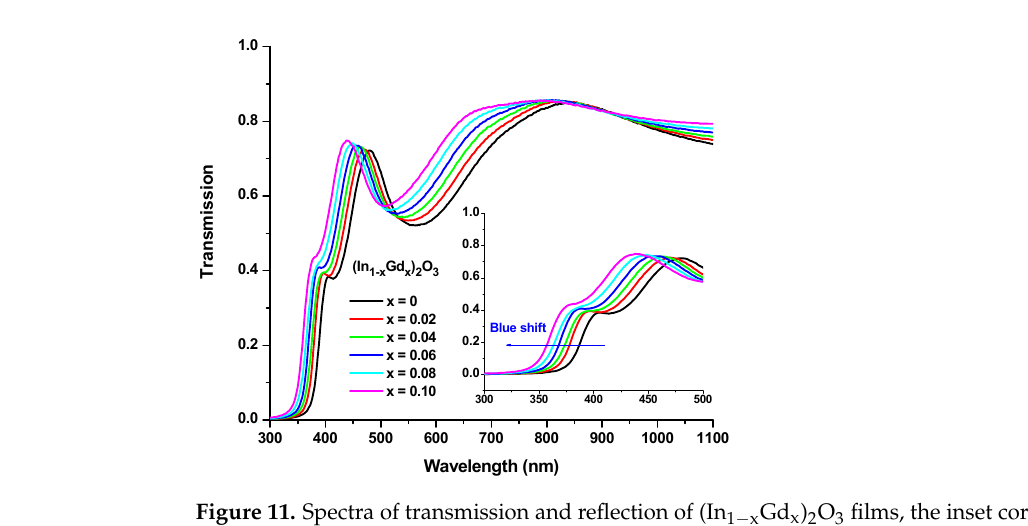
Figure 11. Spectra of transmission and reflection of (In 1 − x Gd x ) 2 O 3 films, the inset corresponds to the strong absorption region of transmission.